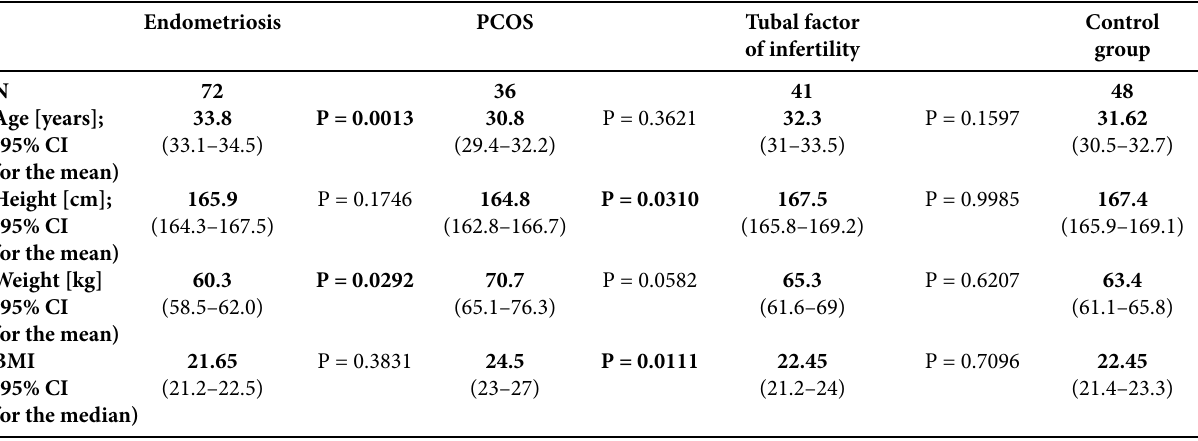
Table 1: Demographic characteristics of the participants (mean or median of individual biomarkers are statistically analyzed and the p values indi- cating the significance of differences between different infertility groups individually with control group obtained by the t test or Mann–Whitney test as